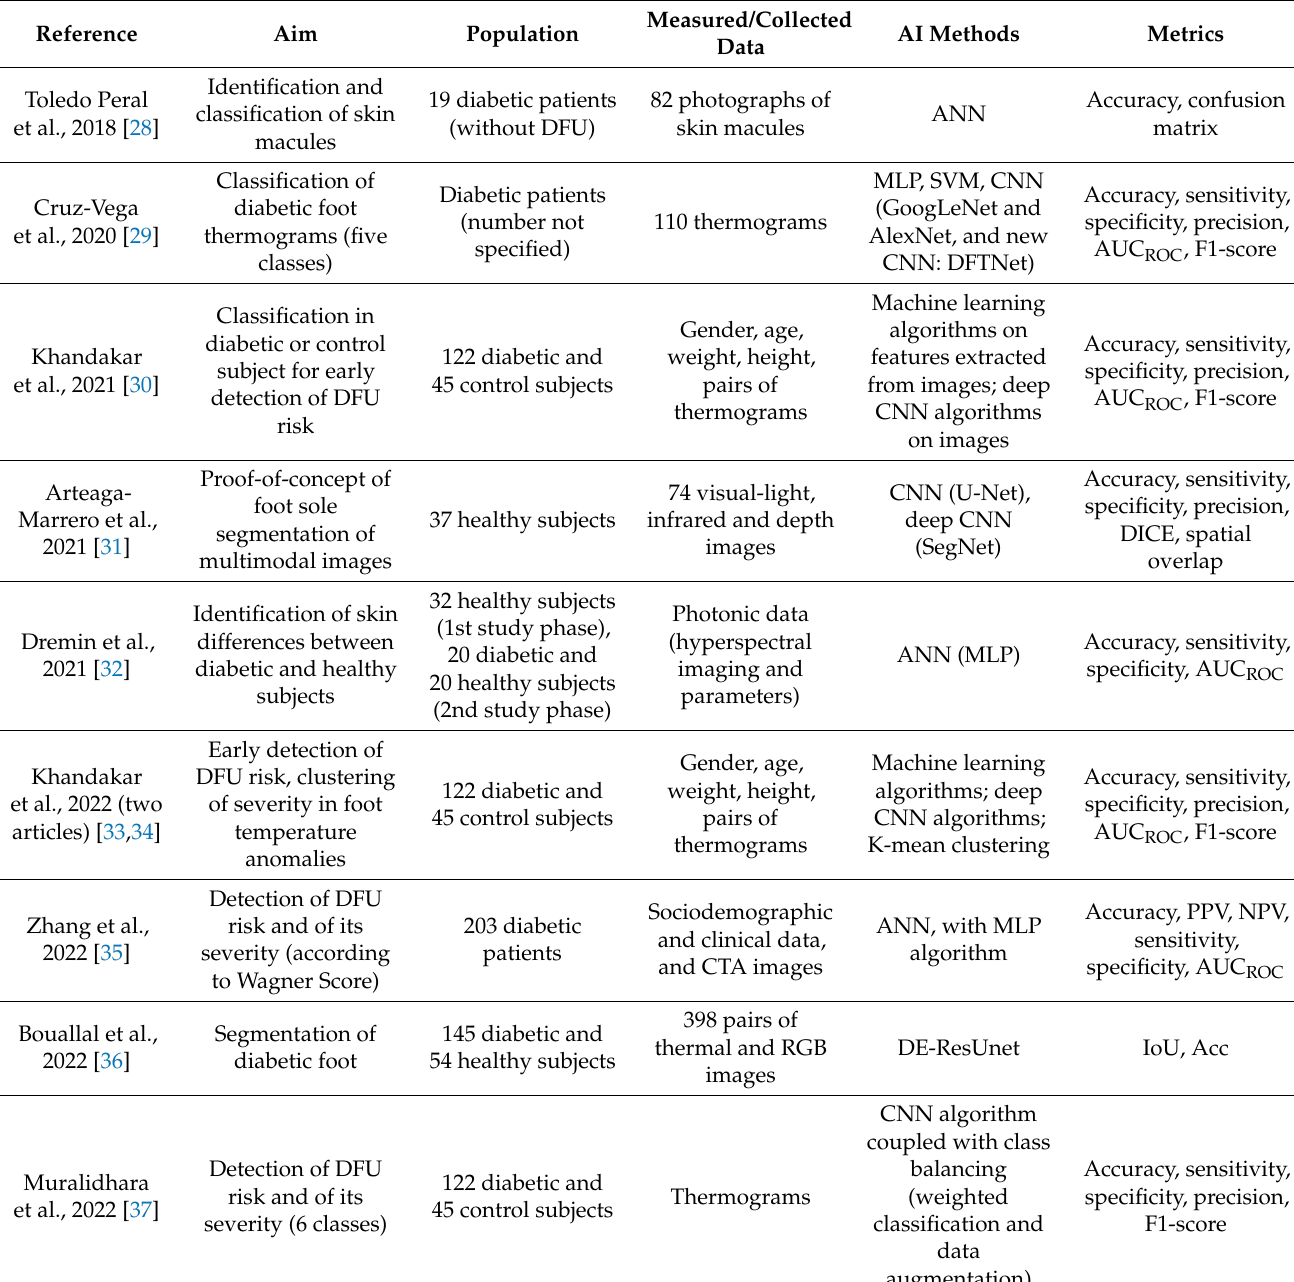
Table 2. Summary information related to the studies concerning diabetic foot syndrome screening— studies based on imaging. The list of abbreviations is reported in the Abbreviations